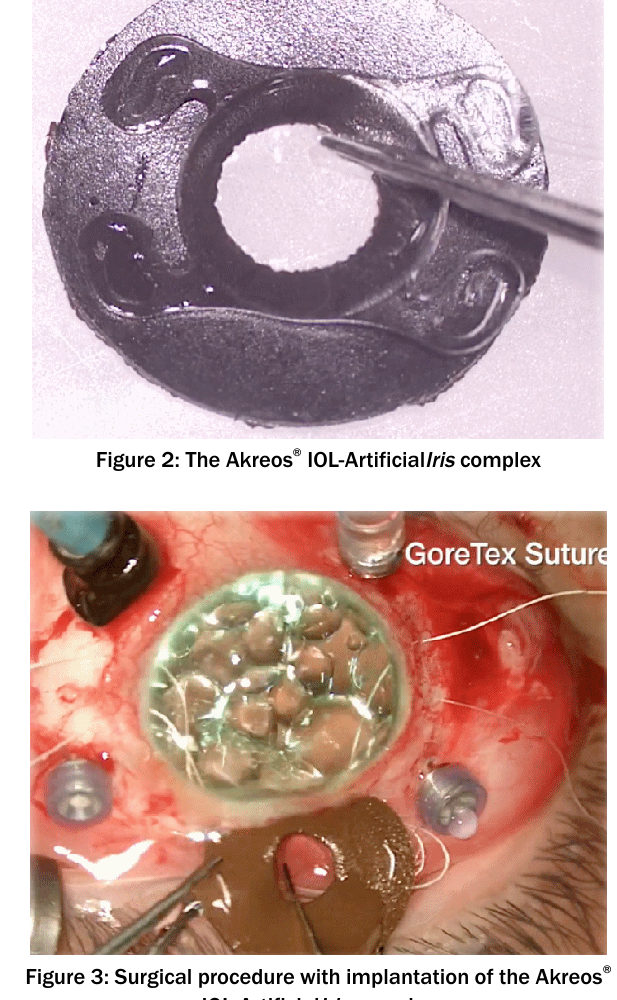
the superior 3.75 mm limbal-based corneal wound.